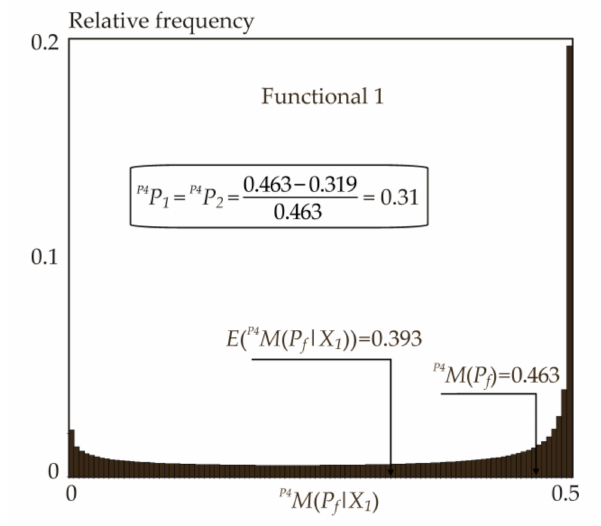
Figure 6. The functional 1-based sensitivity measure P4 M ( P f ).